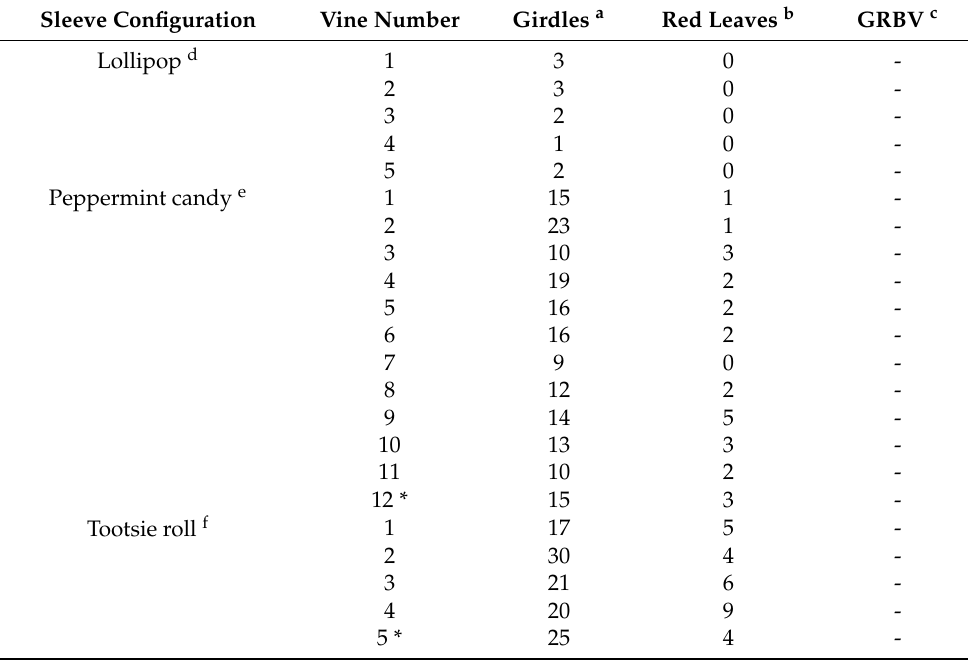
Table 2. Number of girdles and red leaves observed on shoots exposed to viruliferous Spissistilus festinus during the 2021 growing season in New York using three different sleeve configurations. Sleeve Configuration Vine Number Girdles a Red Leaves b GRBV